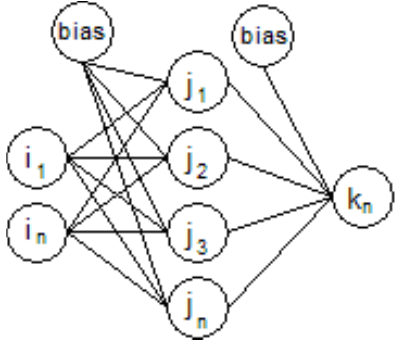
Fig. 1. Structure of a fully interconnected feedforward multi-layer